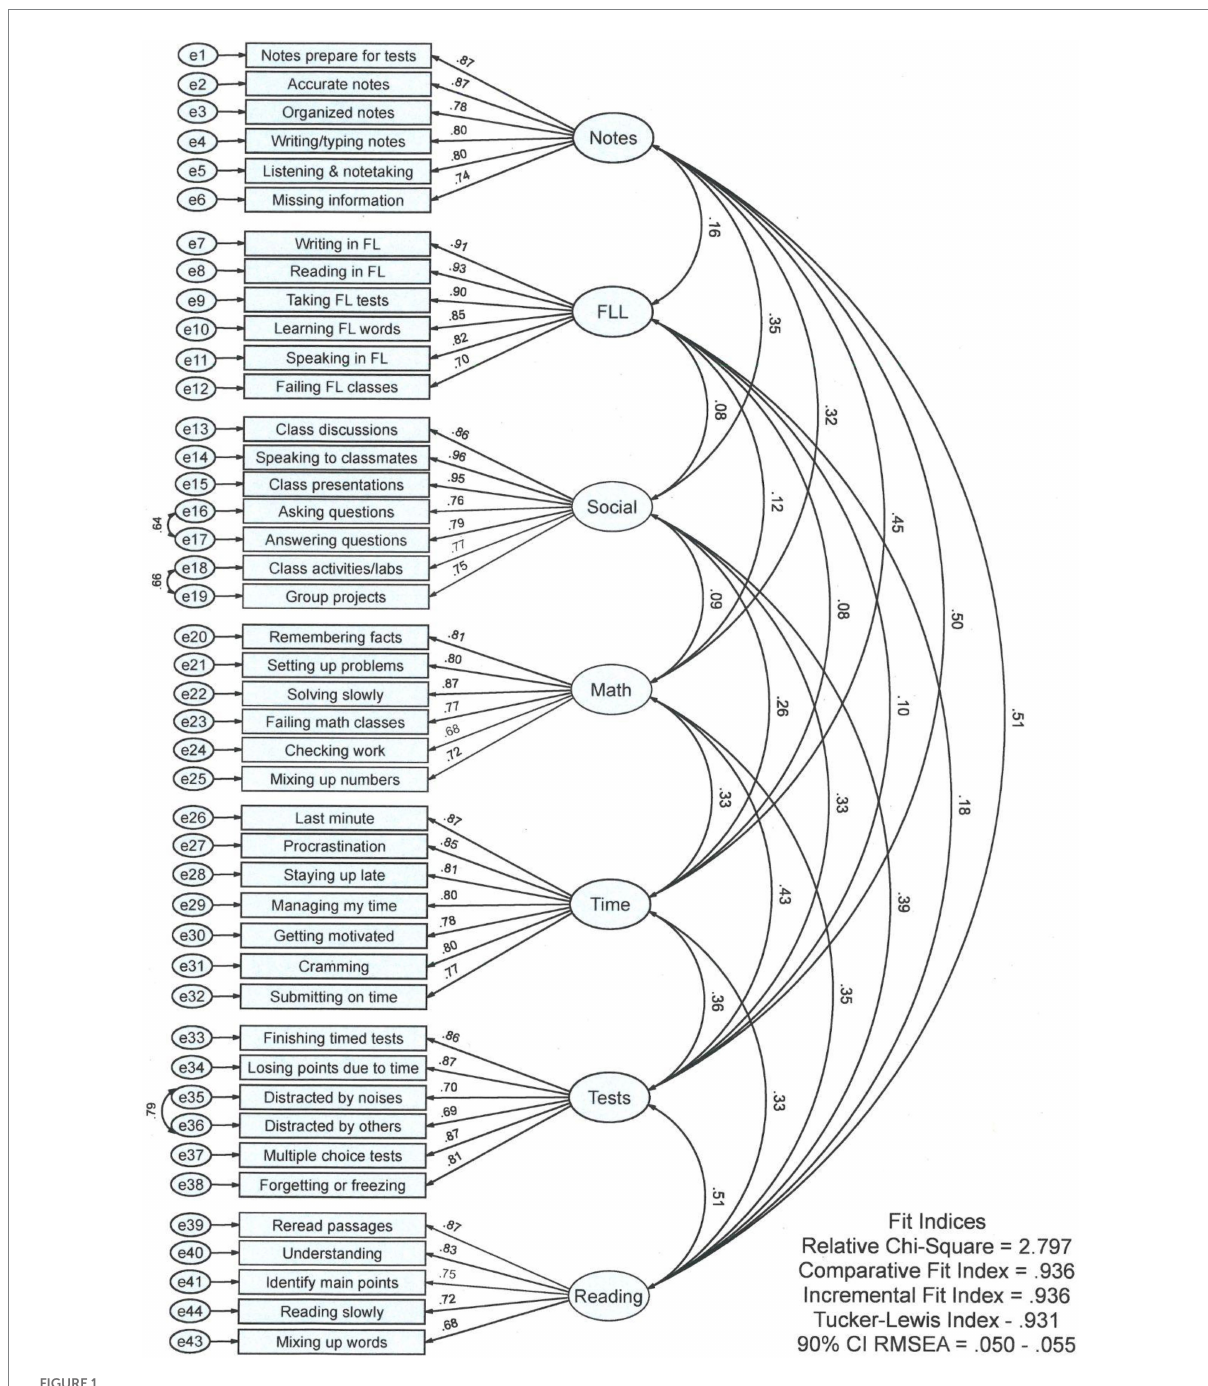
FIGURE 1 Results of confirmatory factor